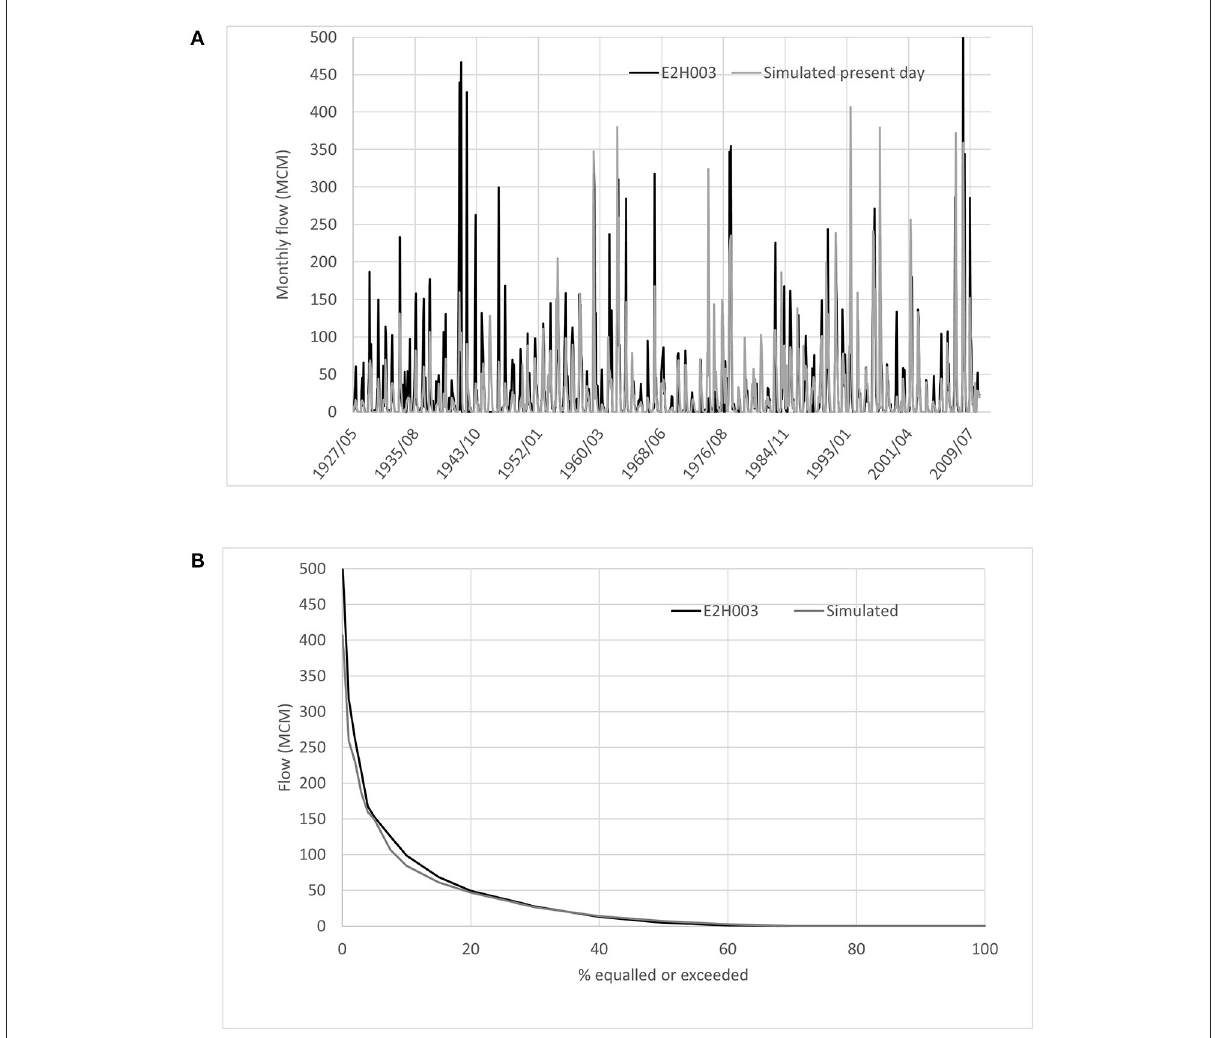
FIGURE3 (A) Hydrograph comparing observed flow from flow gauge (E2H003), and simulated present day flow using the Pitman rainfall-runoff model. (B) Flow duration curve comparing observed data with simulated data (1959–2010) for quaternary catchment where Ecological Reserve site 5 (lower catchment) is